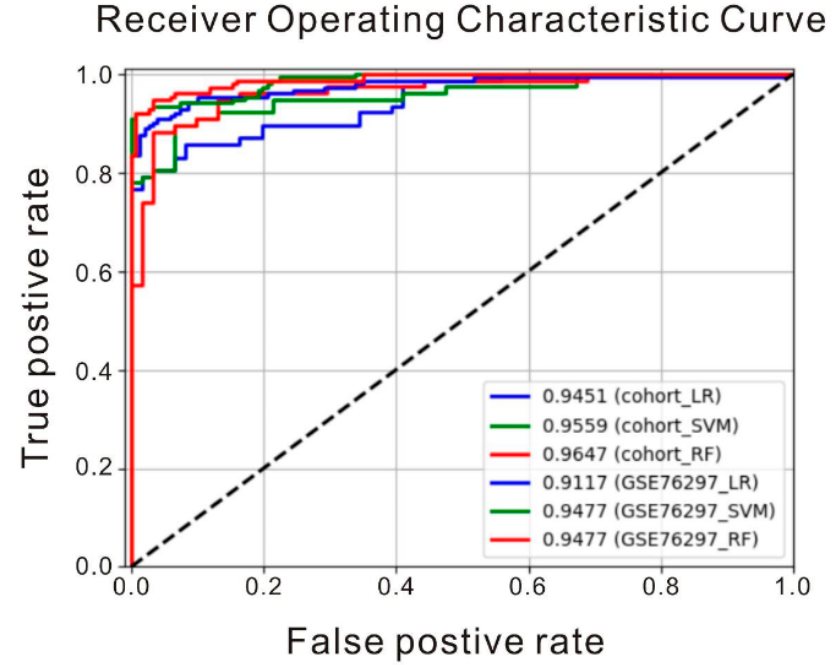
Figure 6. Classification of tumor types using deep learning algorithms. Dataset of an HCC human cohort was used to examine the discriminative power of the biomarkers with high singular AUC scores. Among these biomarkers, six genes (TSPAN8, RBBP5, ENO1, CD55, S100A10, and GSTA1) that showed significant differences between HTC and TW-1 microarray data and two common HCC markers (IL33 and CD44) were selected to train machine learning classifiers for HCC prediction. Three types of machine learning classifiers (logistic regression (LR), support vector machine (SVM), and random forest (RF) were used for each dataset. The predictive power of the classifiers was shown for a human HCC cohort and the human HCC microarray dataset GSE76297.